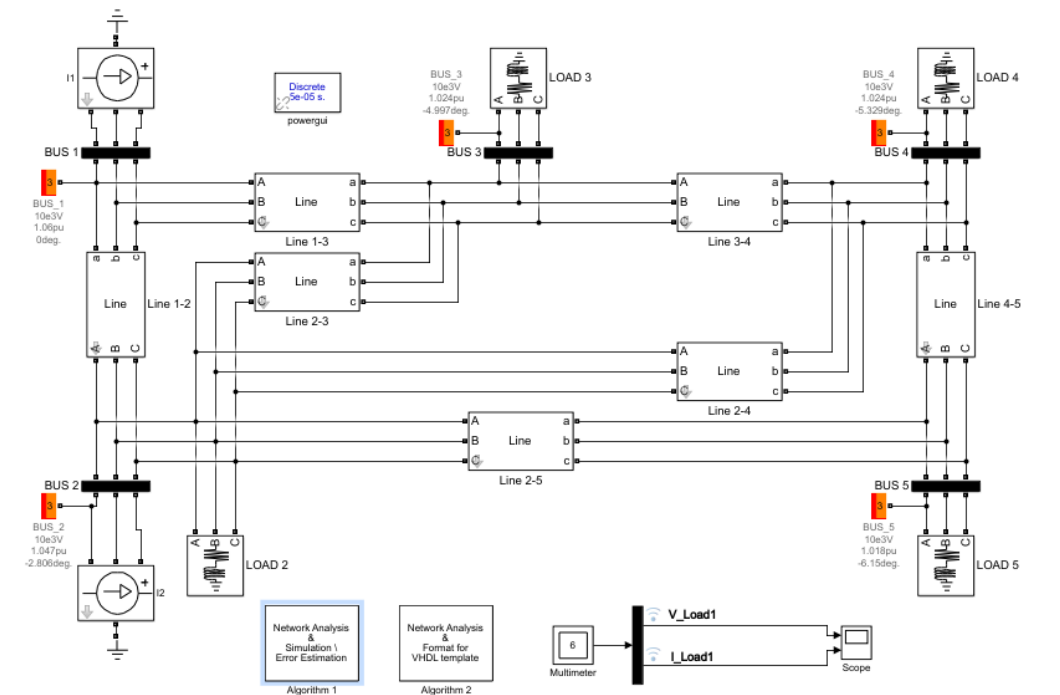
Figure 24. Simulink model of the second test